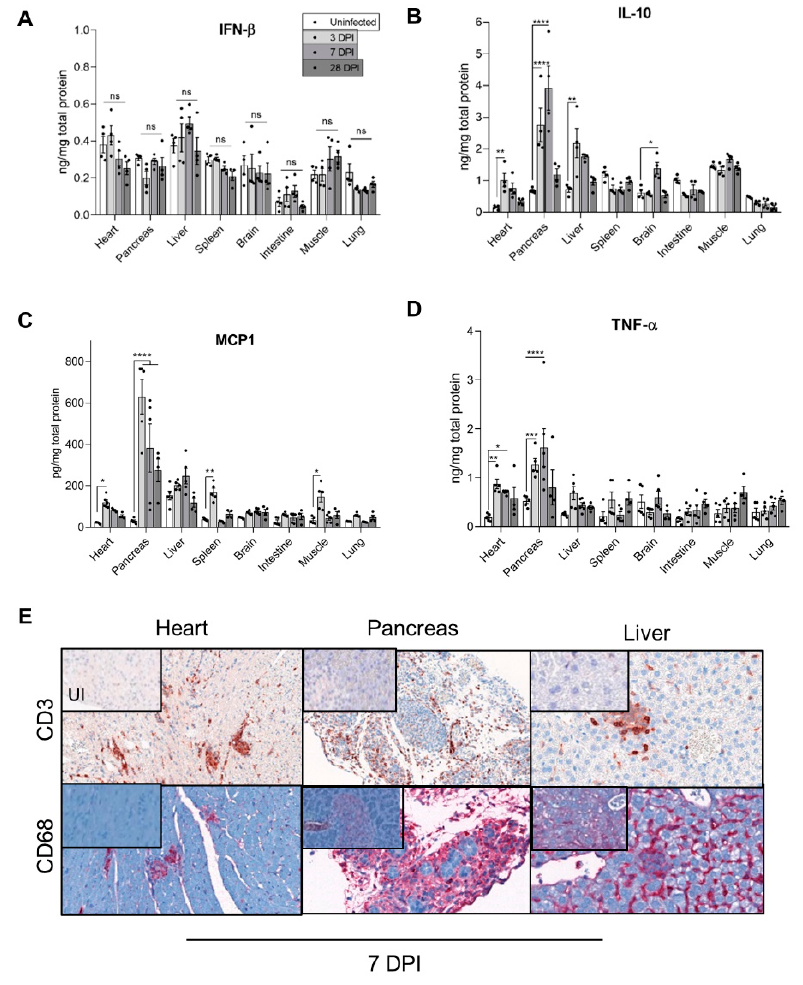
Figure 3. Inflammatory response in organs of CVB3/28-infected DBA/2J mice. ( A – D ) IFN- β , IL-10, TNF- α , and MCP1 levels were measured by ELISA in homogenized organs supernatants of CVB3/28-infected DBA/2J mice and compared to cytokines levels in homogenized organs supernatants of uninfected DBA/2J mice ( n = 4 to 5). Data represent mean +/ − SEM (Mann–Whitney U test; *: p < 0.05; **: p < 0.01; ***: p < 0.001; ****: p < 0.0001; ns or not specified: non-significant). ( E ) Positive CD3 and CD68 cells were found in inflammatory foci or infiltrates at 7 DPI only in the heart, pancreas, and liver. They were absent in other organs and in uninfected mice. Original magnification: heart, 200 × ; pancreas and liver, 400 × . DPI: Days Post Infection. UI: